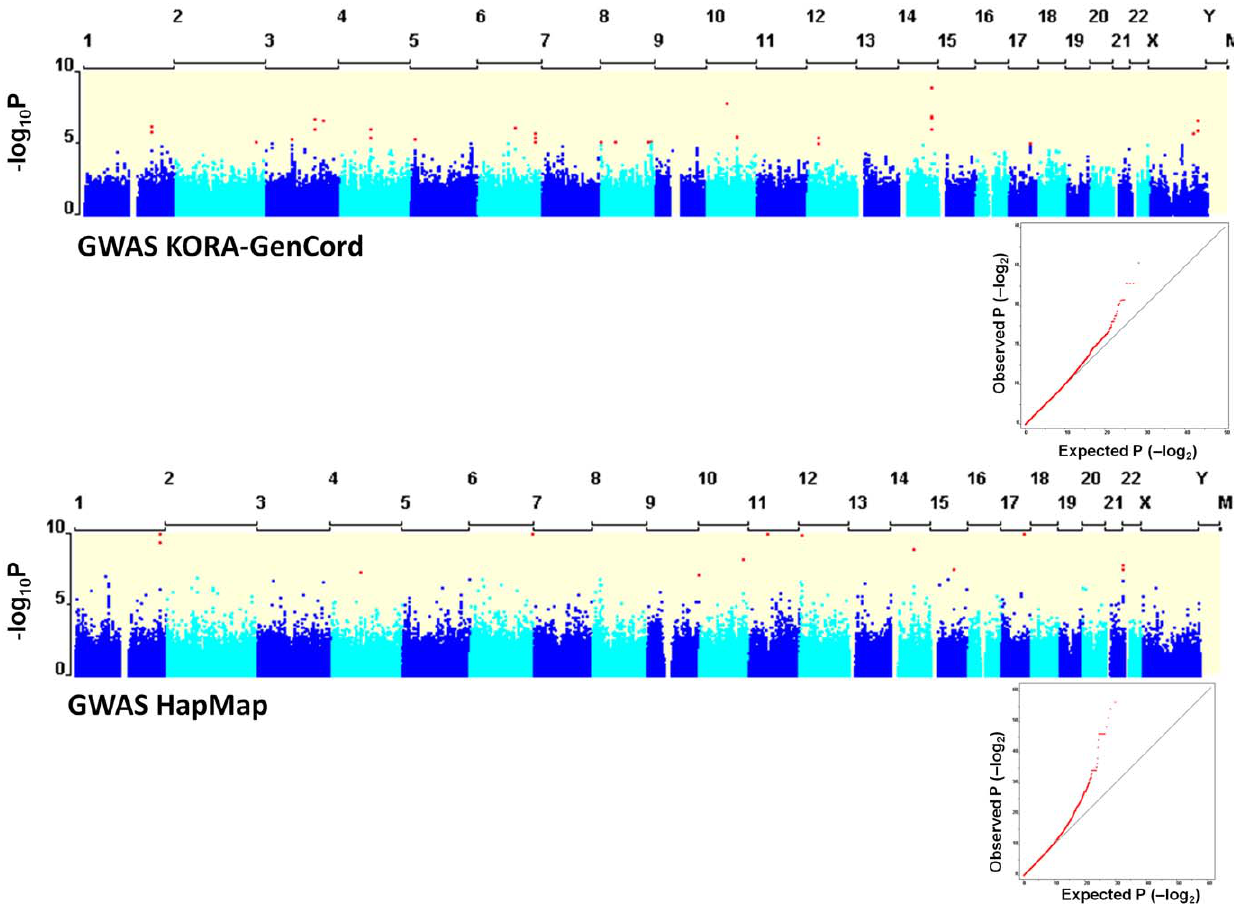
Figure 3. Genome-wide association results for natural variation of H 2 O 2 release in KORA-GenCord and HapMap cohorts. Manhattan dot plots show results for genome-wide association analysis for the KORA-GenCord and the HapMap sample cohorts. The blue dots represent the association finding of one single SNP with natural variation in H 2 O 2 release. Light and dark blue colors distinguish subsequent chromosomes. We did not analyze genetic markers for mitochondrial SNPs in this study. We show results of a genetic additive model indicating the unadjusted nominal 2 log 10 of p-values. Quantile plots show the observed versus the expected distribution of GWAS for both analyses.